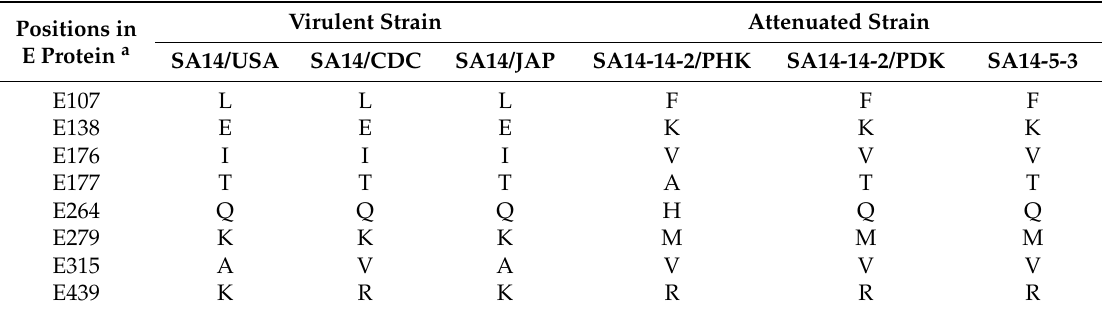
Table 1. Amino acid differences in the viral E protein between Japanese encephalitis virus (JEV)